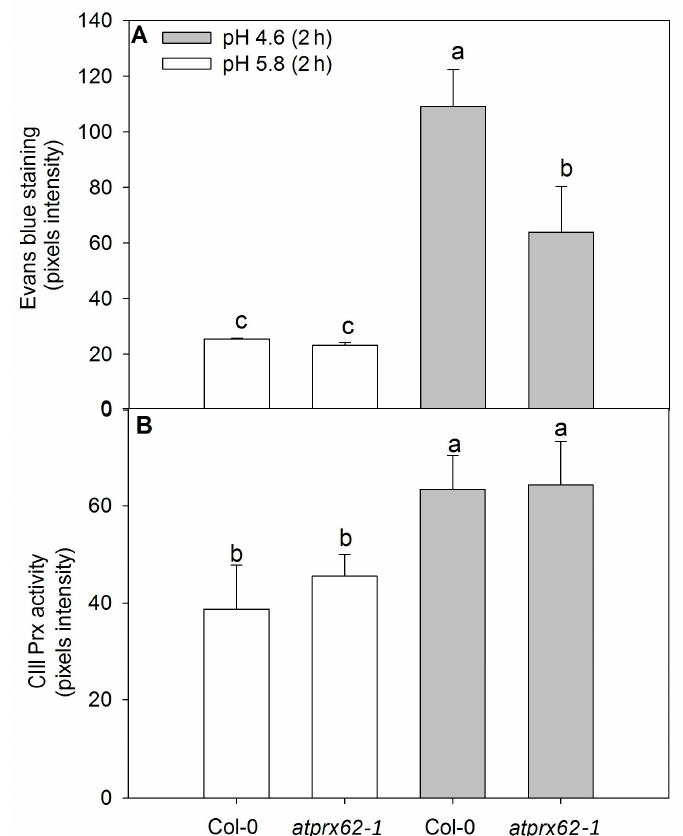
Figure 5. Comparison of cell mortality and CIII Prx activity in roots of Arabidopsis thaliana Col-0 and the atprx62-1 (KO mutant) treated at pH 5.8 or 4.6 for 2 h. The pixels from the images were counted in regions of interest extending up to 500 μ m from root tips stained with Evans blue (cell death) or up to 350 μ m from root tips stained with a guaiacol/H 2 O 2 assay (CIII Prx activity) (see dashed lines in Figure 4A–D, J–M for examples). ( A ) The increase in pixels’ intensity indicates an increase in cell death. ( B ) The increase in pixels intensity indicates an increase in CIII Prx activity. The bars are the standard error of three independent experiments. Di ff erent letters (a, b and c) indicate significant di ff erences Statistical analysis was performed by Duncan’s test. Note the good correlation between low pH-induced cell death and CIII Prx activity. Note that the decreased cell death observed in atprx62-1 as compared to WT was not followed by a reduction in CIII Prx